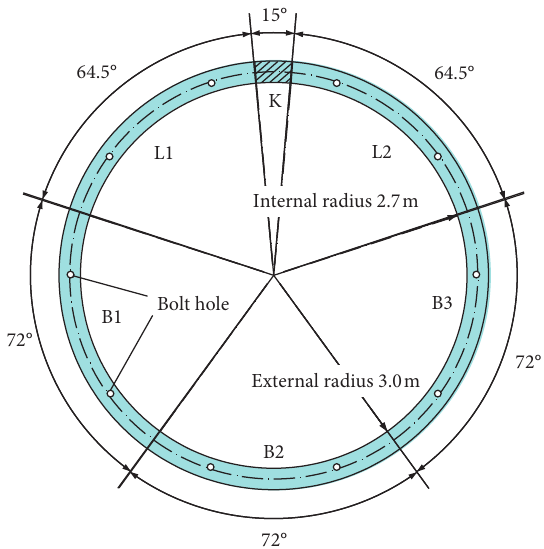
Figure 4: Cross section of the segmental